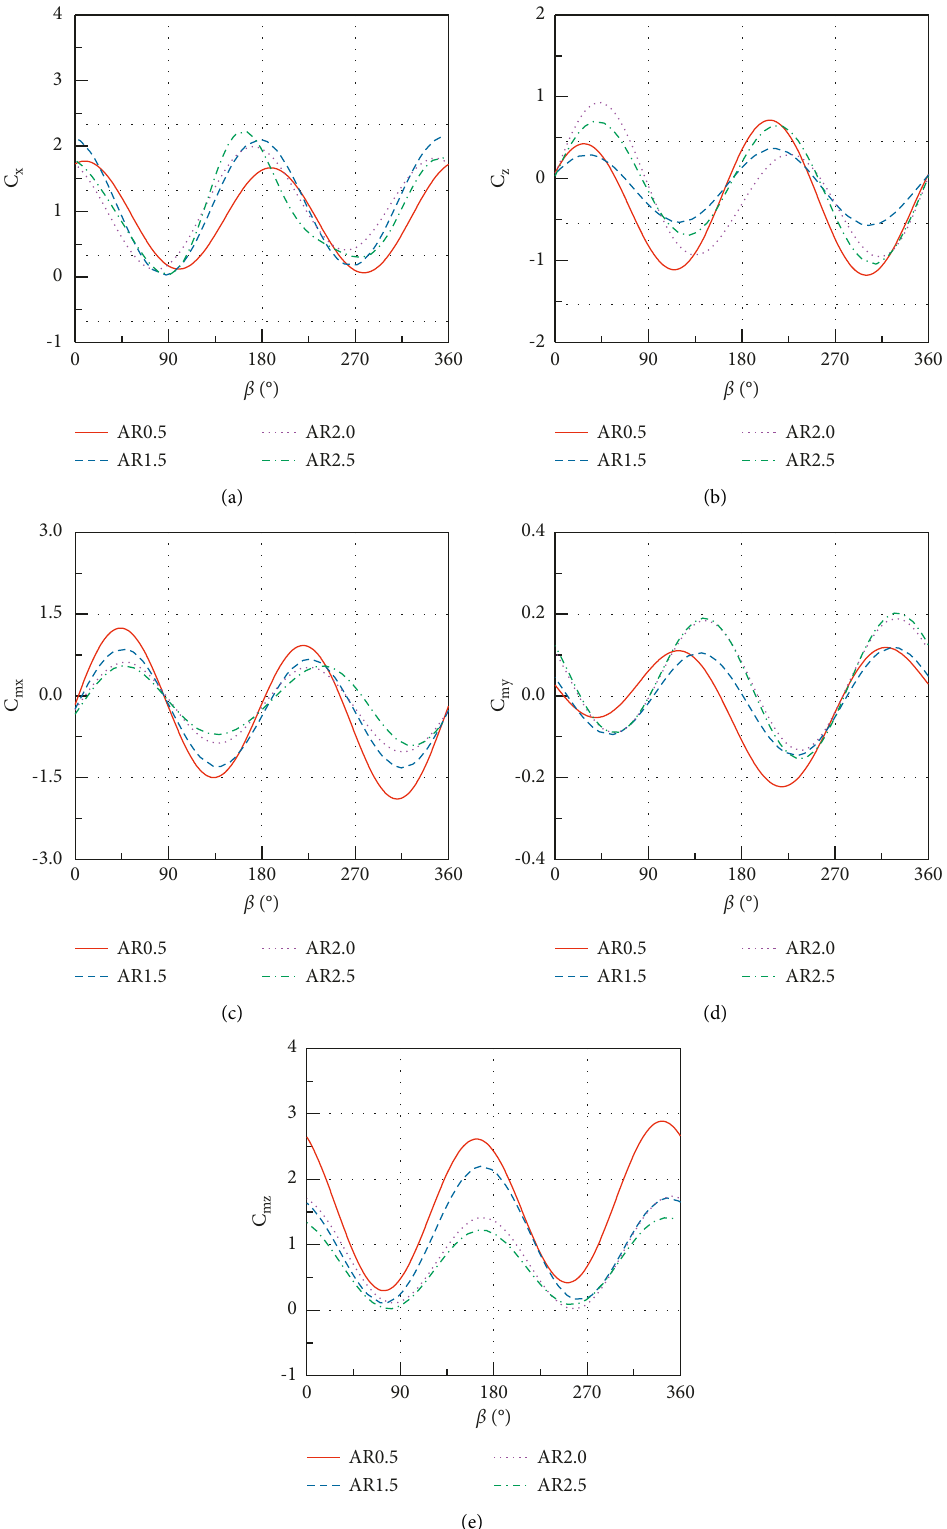
Figure 5: Aerodynamic coefficients with respect to the aspect ratio ( K � 0.12): (a) C